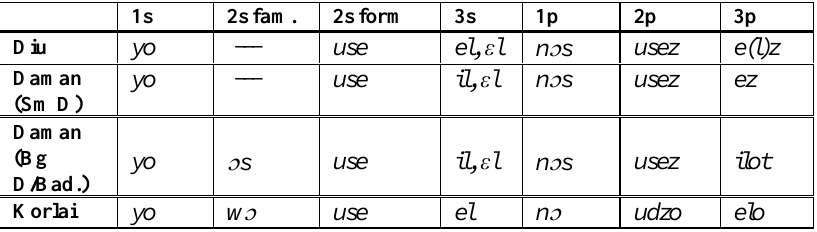
Table X. Subject pronominal systems in Diu, Daman, and Korlai (Cardoso, 2009: 131- -132 for Diu; Clements & Koontz-Garboden, 2002: 207-209 for Daman and Korlai)